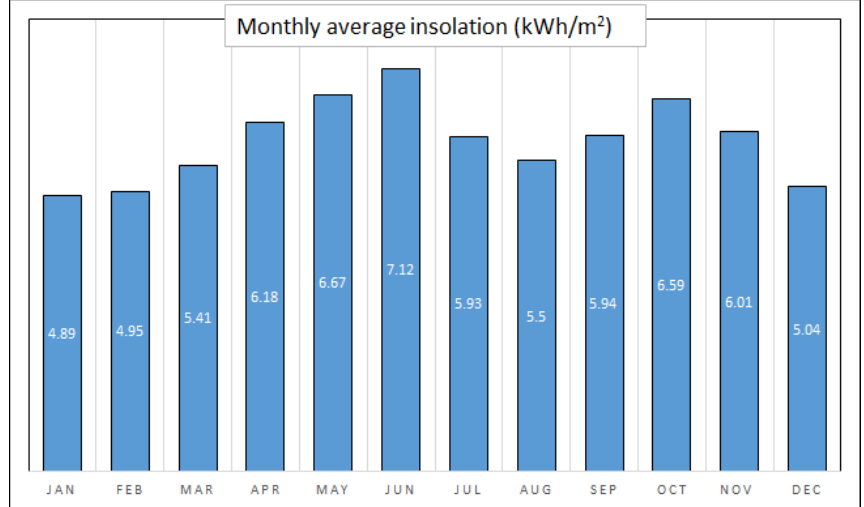
Figure 3. Average solar insolation data for